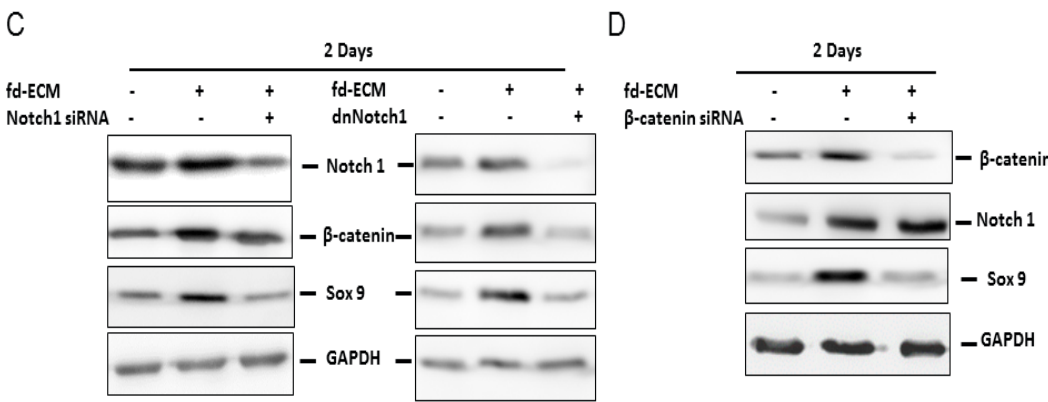
Figure 8. Chondrogenic differentiation of ad-MSCs in the presence of fd-ECM requires activation of Notch1 and β -catenin signaling. Ad-MSCs were cultured on plastic dishes ( − ) or on the fd-ECM (+) for the indicated number of days ( A , B ) Ad-MSCs cultured on plastic control dishes and on fd-ECM were evaluated for β -catenin expression using immunofluorescence assay. Ad-MSCs, cultured for two days and four days, were incubated with antibodies against β -catenin and DAPI was used to stain the DNA in the nucleus. Scale bar: 100 µm; ( C ) Ad-MSCs were transfected with Notch1 siRNA and the dominant negative Notch1 construct using Transfectin Lipid reagent. Evaluation of Notch1, Sox9 and β -catenin protein levels was done; and ( D ) ad-MSCs were transfected with β -catenin siRNA as described above and Notch1, Sox9, and β -catenin protein level was determined.